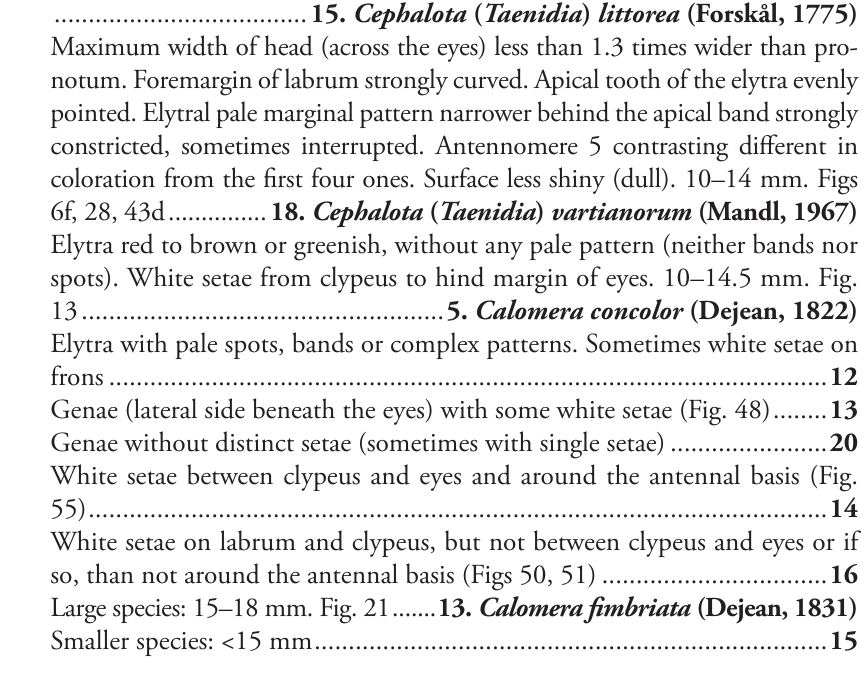
Elytral pale pattern on the disc reduced and constricted, forming spots which are (partly) connected with the pale margin. 9–13 mm. Fig. 35 .................... – Elytral pale patterns not or slightly constricted, forming complex bands, not spots; at least middle band bent downwards, sometimes s-shaped (Figs 25, 26, 28, 31, 32) ............................................................................................ 8 8 Labrum without or with 1 median tooth (Fig. 6b, c, f) ............................... 9 – Labrum with 3 or more teeth (Fig. 6h). Pale elytral margin wide. Longitudi- nal row of punctuation parallel to elytral suture. 11–15 mm. Figs 26, 43b .... ...................................... 16. Cephalota ( Taenidia ) tibialis (Dejean, 1822) 9 Labrum with more than 8 setae (Fig. 6b). Elytra in the apical third angularly pointed. Pale elytral pattern strongly bent, middle band s-shaped. 9–10.5 mm. Figs 6b, 31, 32, 44a .................................... 20. Cylindera ( Eugrapha ) contorta (Fischer von Waldheim, 1828), ssp. valdenbergi (Mandl, 1981) – Labrum with less than 8 setae (Fig. 6c, f). Elytra more evenly rounded. Pale pattern with only slightly bent bands. Specimens regularly larger than 10 mm ........................................................................................................... 10 10 Maximum width of head (across the eyes) more than 1.3 times wider than pronotum. Fore margin of labrum weakly curved. Apical tooth of the elytra sharply pointed. Elytral pale marginal pattern behind the basal band wider. Antennomeres 5 and following ones less contrasting in coloration from the first four ones. Surface shinier. 10–12 mm. Figs 6c, 25, 43a .......................... ..................................... 15. Cephalota ( Taenidia ) littorea (Forskål, 1775) – Maximum width of head (across the eyes) less than 1.3 times wider than pro- notum. Foremargin of labrum strongly curved. Apical tooth of the elytra evenly pointed. Elytral pale marginal pattern narrower behind the apical band strongly constricted, sometimes interrupted. Antennomere 5 contrasting different in coloration from the first four ones. Surface less shiny (dull). 10–14 mm. Figs 6f, 28, 43d ............... 18. Cephalota ( Taenidia ) vartianorum (Mandl, 1967) 11 Elytra red to brown or greenish, without any pale pattern (neither bands nor spots). White setae from clypeus to hind margin of eyes. 10–14.5 mm. Fig. 13 ..................................................... 5. Calomera concolor (Dejean, 1822) – Elytra with pale spots, bands or complex patterns. Sometimes white setae on frons ......................................................................................................... 12 12 Genae (lateral side beneath the eyes) with some white setae (Fig. 48) ........ 13 – Genae without distinct setae (sometimes with single setae) ....................... 20 13 White setae between clypeus and eyes and around the antennal basis (Fig. 55) ............................................................................................................ 14 – White setae on labrum and clypeus, but not between clypeus and eyes or if so, than not around the antennal basis (Figs 50, 51) ................................. 16 14 Large species: 15–18 mm. Fig. 21 ....... 13. Calomera fimbriata (Dejean, 1831)